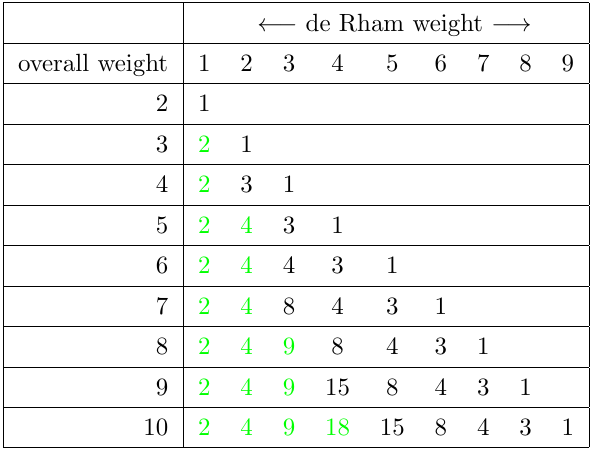
Table 14 . Dimensions of the space K (cid:25) of de Rham entries of the coaction of hexagon functions restricted to the line ( u; u; 1). The green entries mark spaces that are saturated, in the sense that all possible functions in K (cid:25) at the given weight, cf. eq. (7.8), appear as independent de Rham entries of the